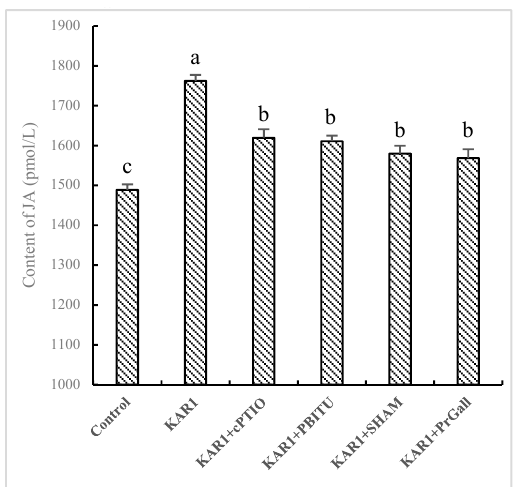
Figure 4. Effects of inhibitors on KAR 1 -induced JA accumulation in S. miltiorrhiza hairy root. S. miltiorrhiza hairy root treated with KAR 1 , and various inhibitors were harvested at 12 h after KAR 1 and NO contents were determined. Inhibitors were pretreated 1 h before treatment of KAR 1 . The control received vehicle solvent only. Data are means of three replicates ± SD. Different letters indicate significantly different values according to one-way ANOVA followed by Tukey’s test ( p < 0.05).